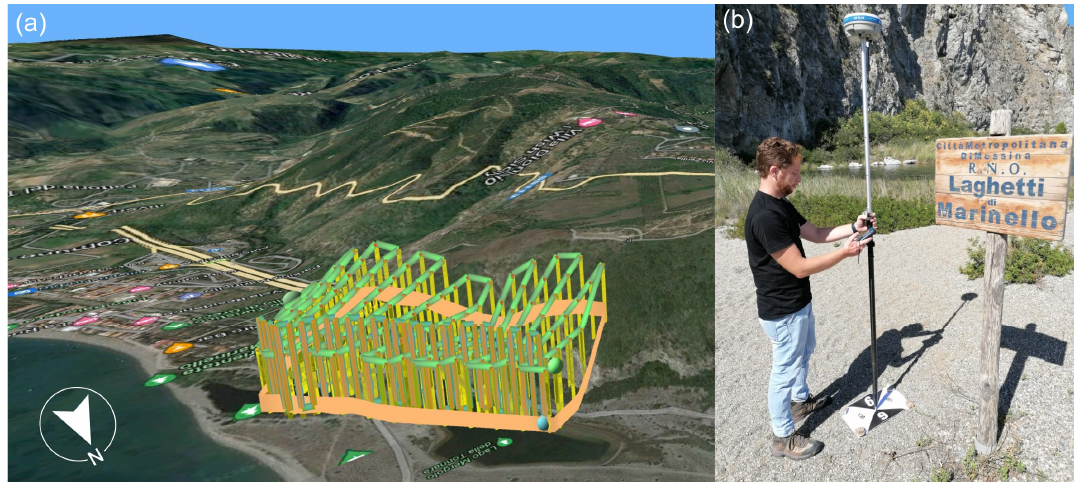
Figure 3. ( a ) nadiral and oblique flight planes; ( b ) phase of the GPS datum acquisition at a GCP.